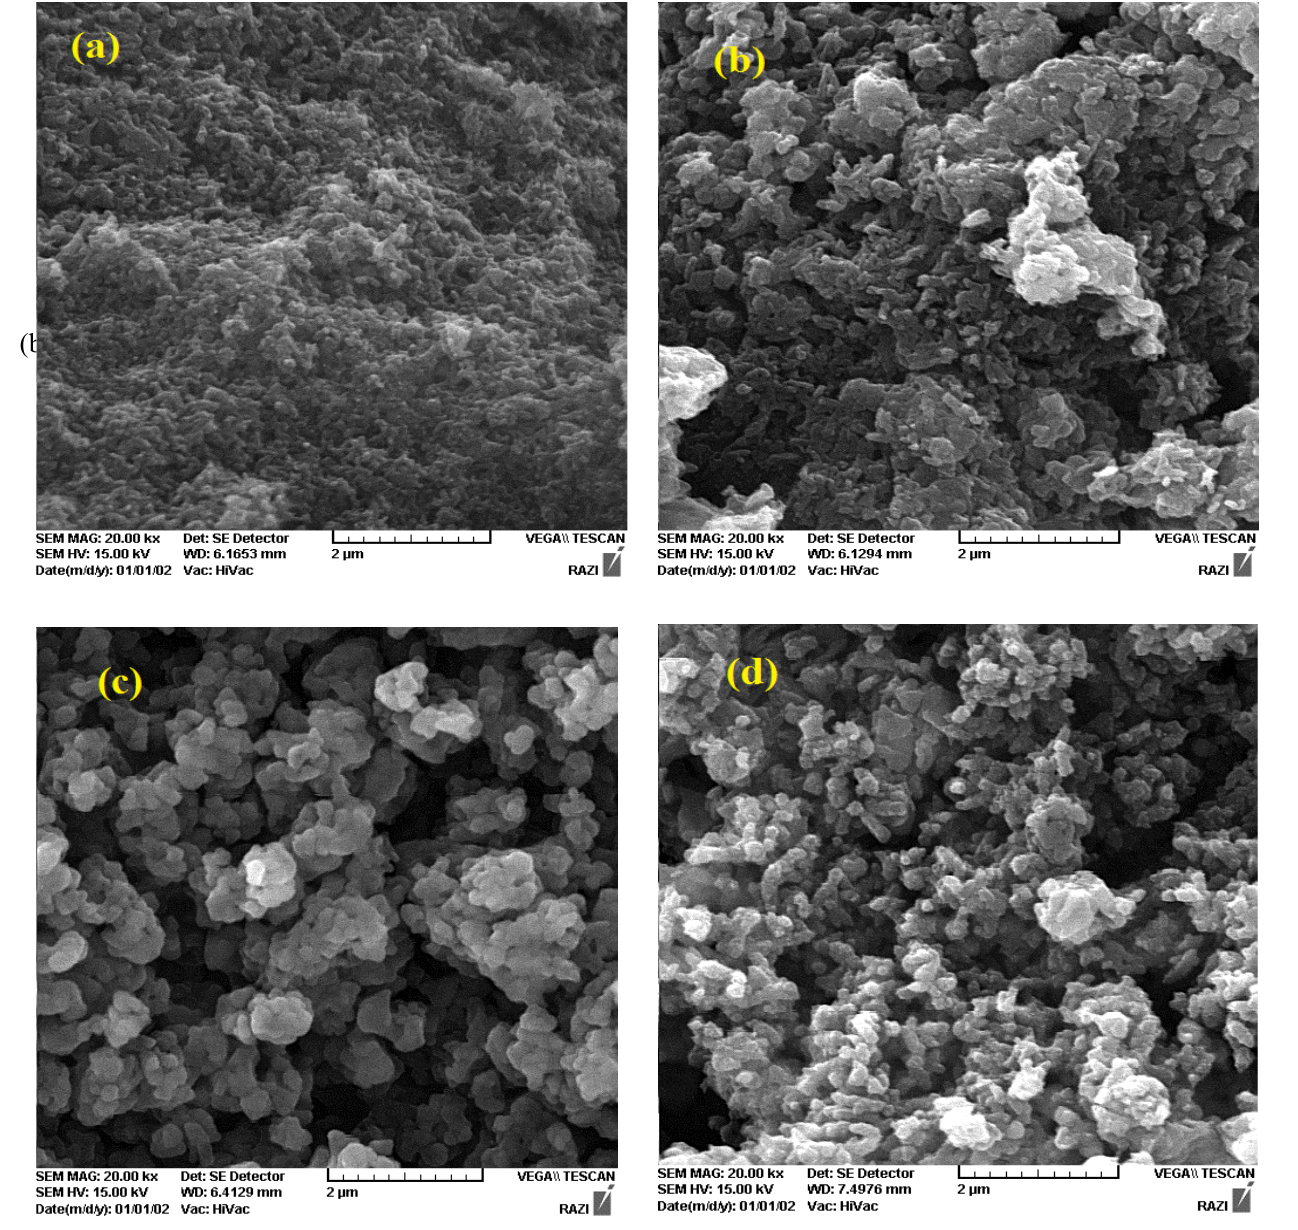
Fig. 3. Scanning electron micrograph of (a) PAn/HPC, (b) PAn/PEG, (c) PAn/PVA and (d) PAn/DBSNa in aqueous media. Reaction conditions: (NH